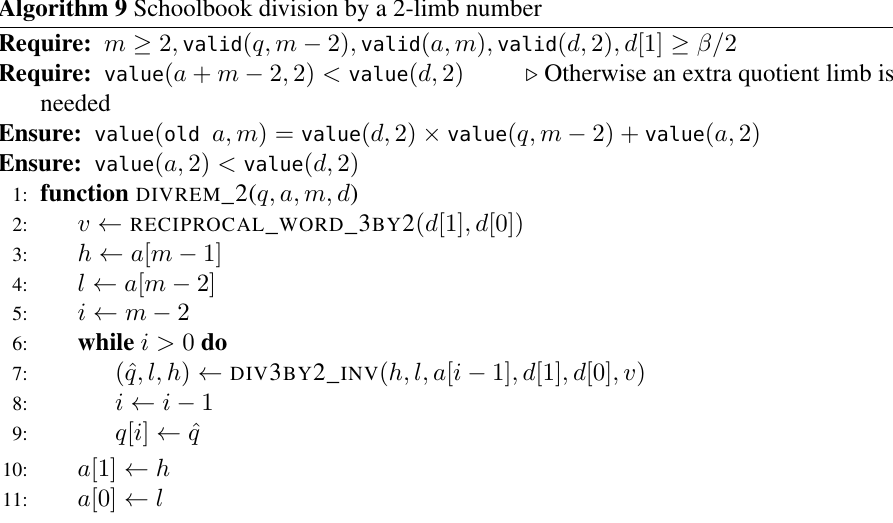
Algorithm 9 Schoolbook division by a 2-limb